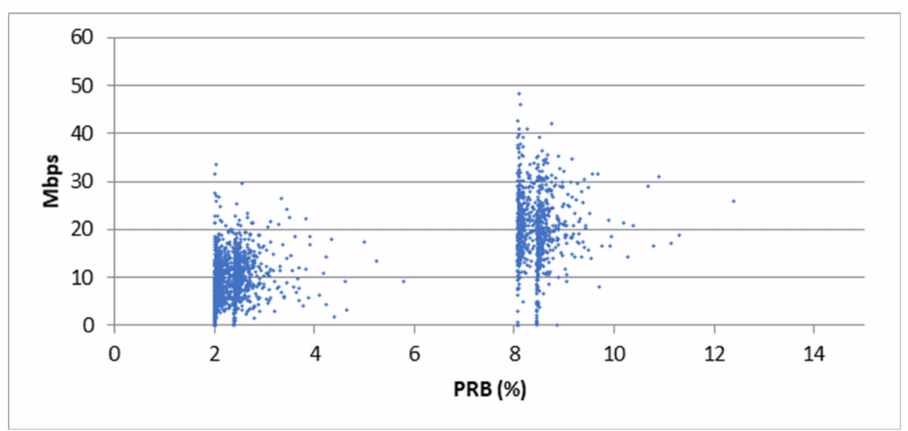
Figure 6. Cell throughput vs. PRBs for 10 MHz.